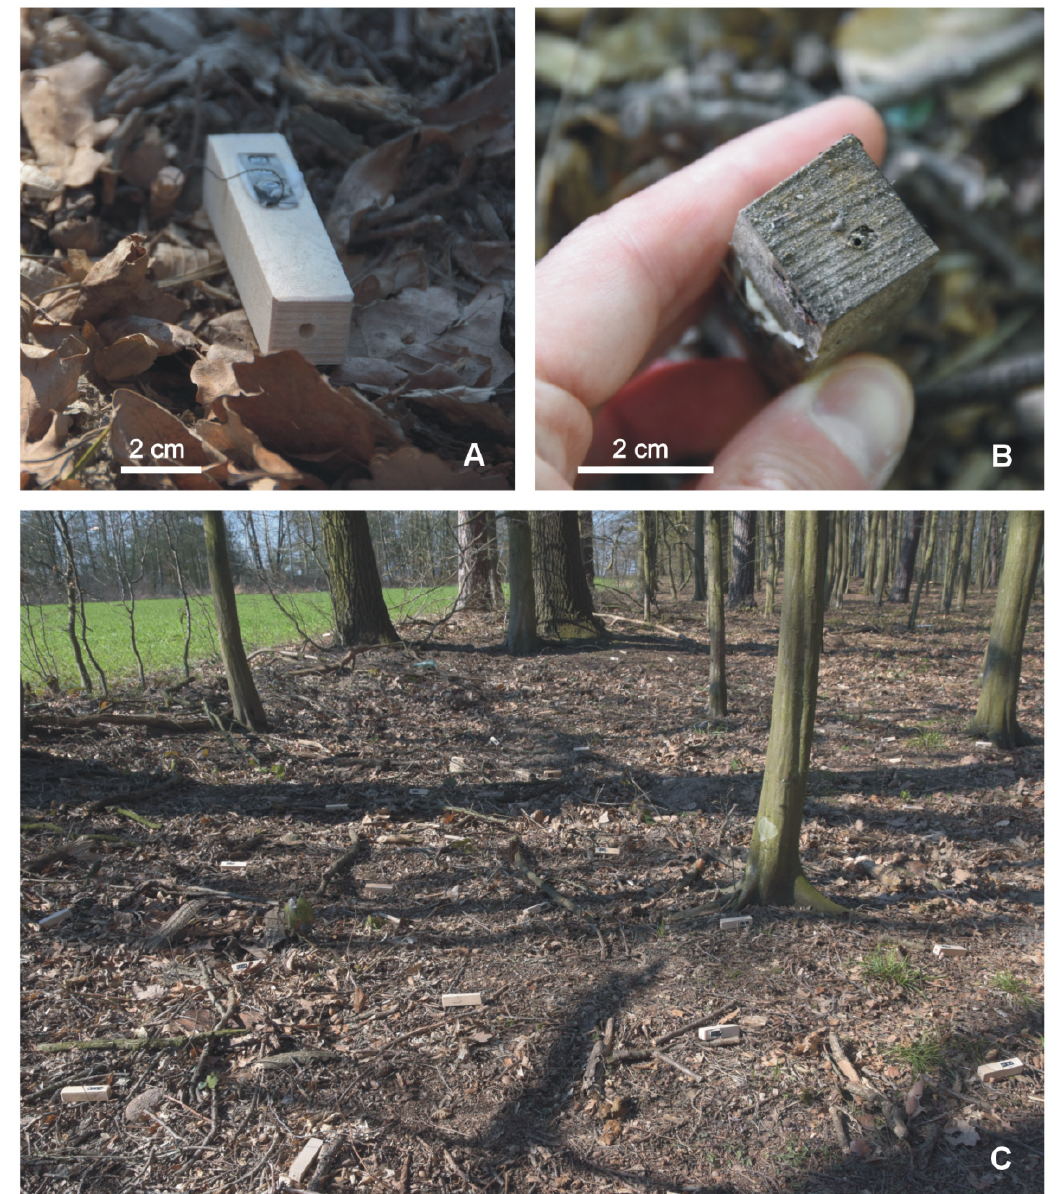
Figure 2. Artificial nest sites used during the field experiments. ( A ) Photograph of an artificial nest site made of a woodblock (see Figure 1). Such nest sites made of woodblocks are readily accepted by acorn ants of the genus Temnothorax . ( B ) Entrance to an artificial nest site modified by the Temnothorax crassispinus ant colony using sand and soil. ( C ) Artificial nest sites made of woodblocks during the field experiment. During this study, the artificial nest sites were located in a beech-pine forest with a few oaks, about 2–6.5 m from the edge of the forest.